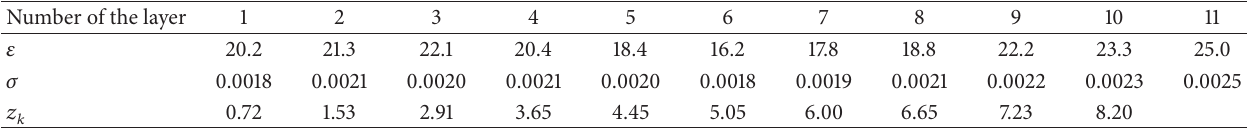
Table 4: Model of the medium 4.